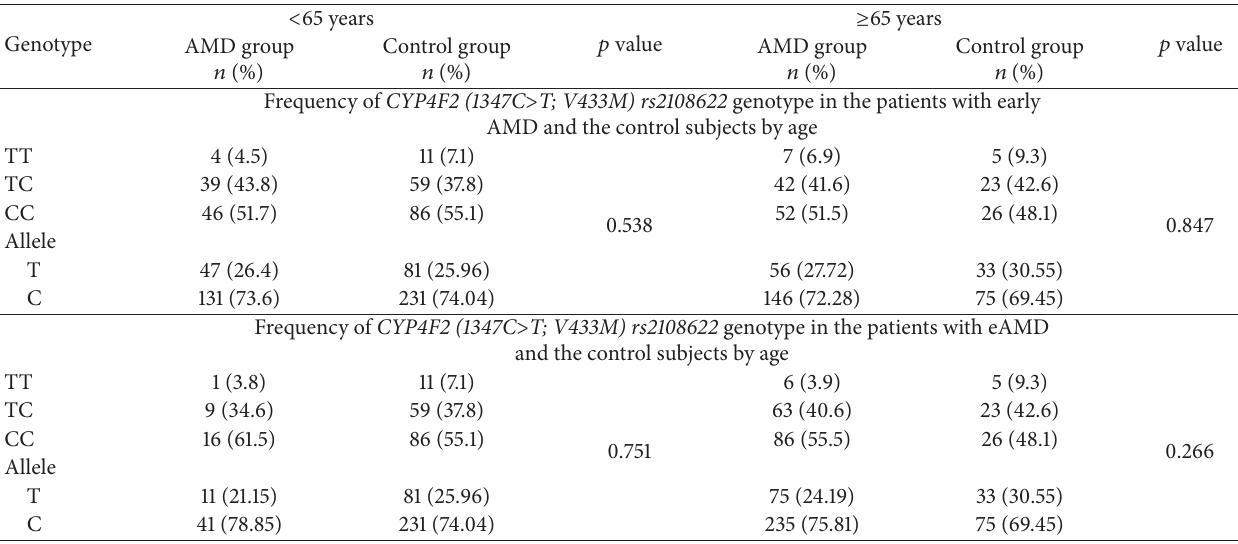
Table 4: Frequency of CYP4F2 rs2108622 genotype in early AMD patients, in eAMD patients and controls by age.